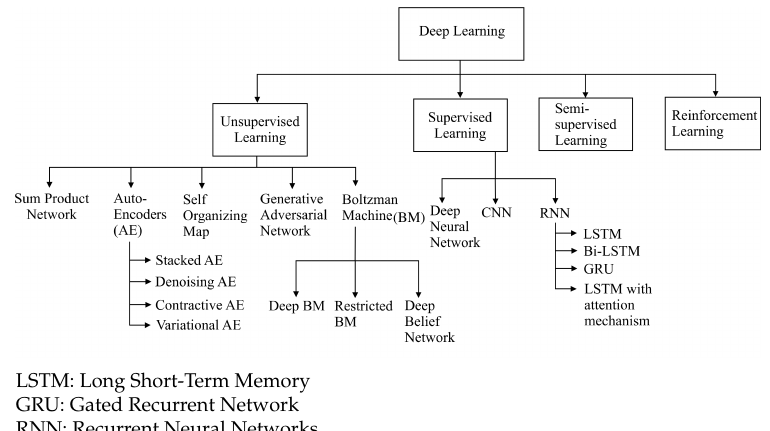
Figure 4. Classification of Deep Learning